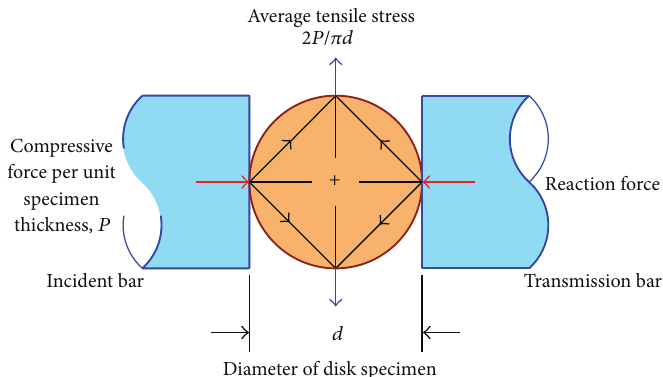
Figure 5: Induced tensile stress in circular disk specimen along transverse direction due to applied compressive loading.